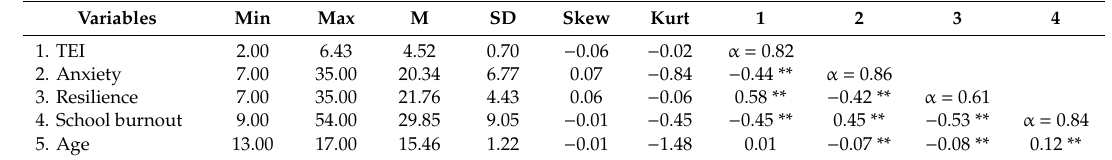
Table 1. Descriptive statistics and intercorrelations between the variables in the study. Variables